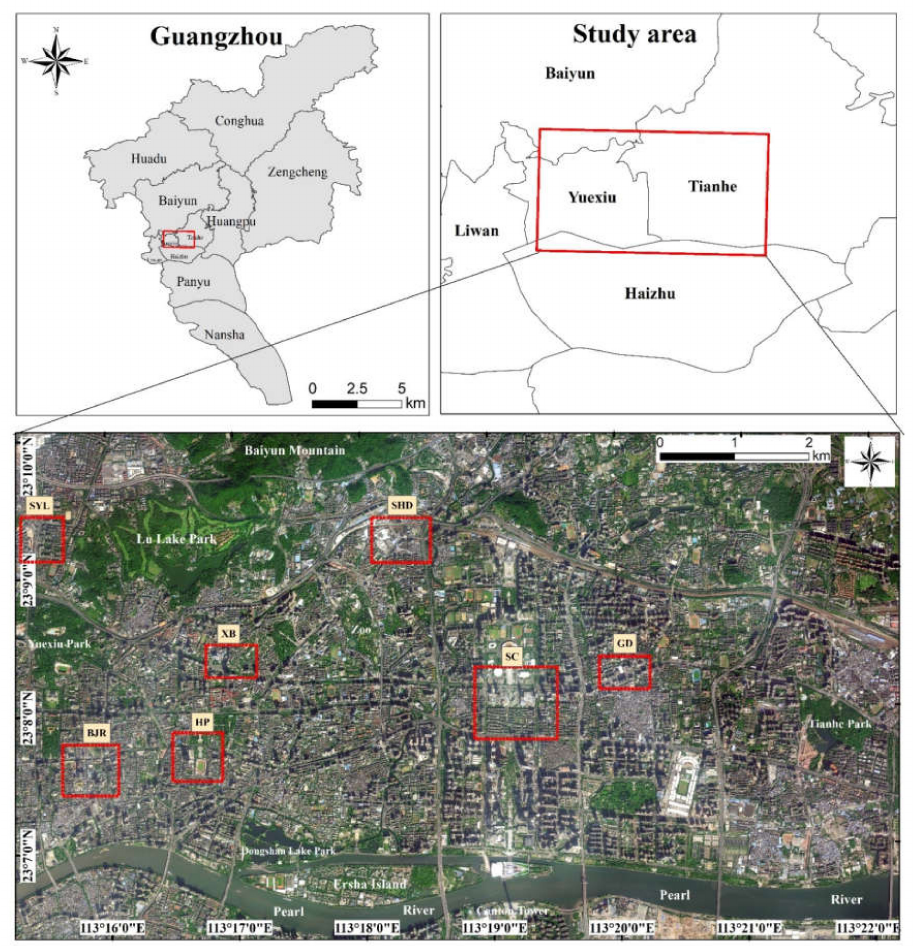
Figure 1. Study area of Guangzhou. SYL: Sanyuanli Business District; SHD: Shaheding Business District; XB: Xiaobei Business District; BJR: Beijing Road Business District; HP: Hero Plaza Business District; SC: Sport Center Business District; GD: Gangding Business